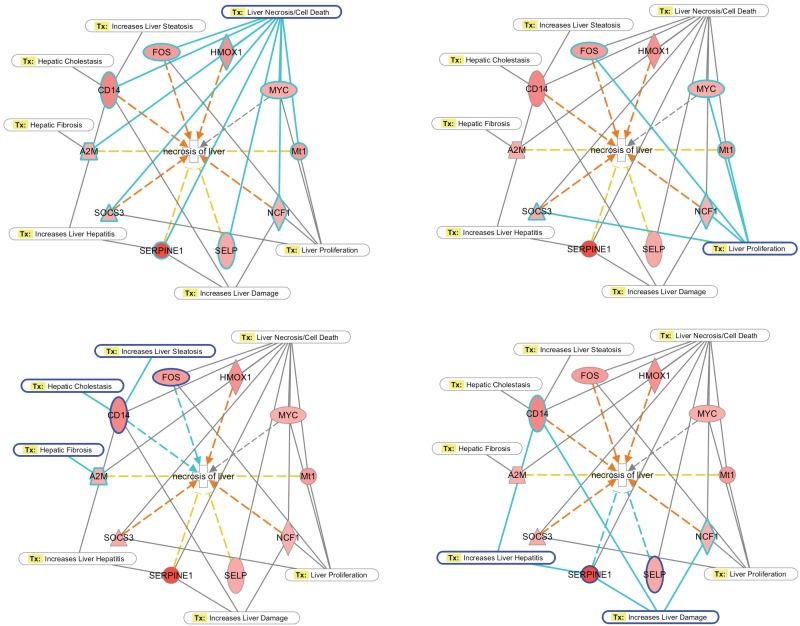
Gene networks associated with hepatic damage.The Ingenuity Pathway Analysis tool was used to identify significant genes that are related to hepatic damage as well as to build up interaction networks amongst them with the most significant associated-functions related to hepatic damage. Solid lines denote direct interactions and dotted-arrows predict activation pathways. The color red indicates up-regulation. The data used for such network construction were the comparison between t0 (uninfected) and t21 (21 days post-infection), which is where the most significant differential expression of genes occurs.